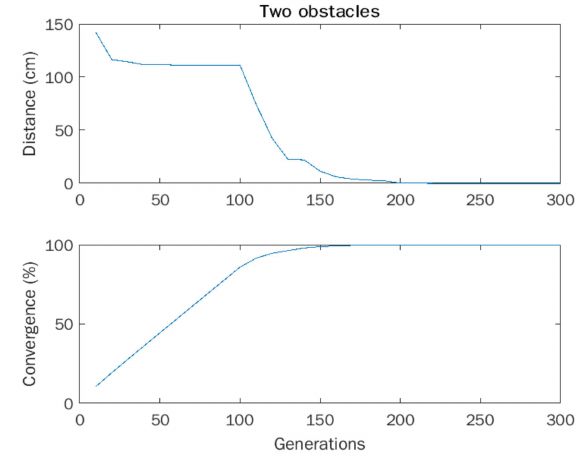
Figure 20. Results of the maze with two obstacles.